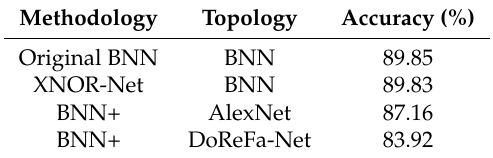
Table 2. Comparison of accuracies on the CIFAR-10 dataset from works presented in this